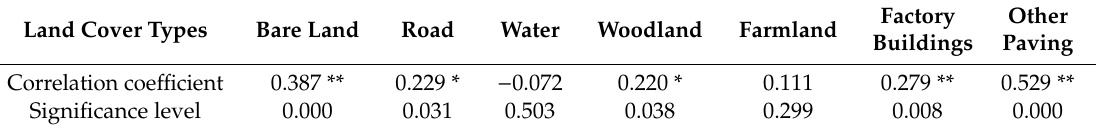
Table 1. Spearman correlation analysis between the population and land cover type.